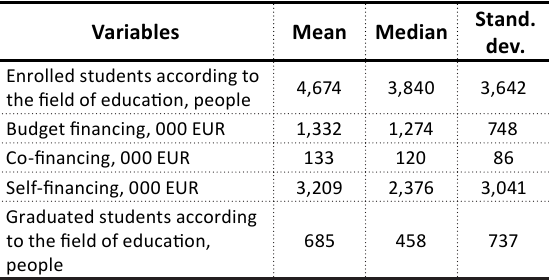
Table 1. Descriptive statistics for a